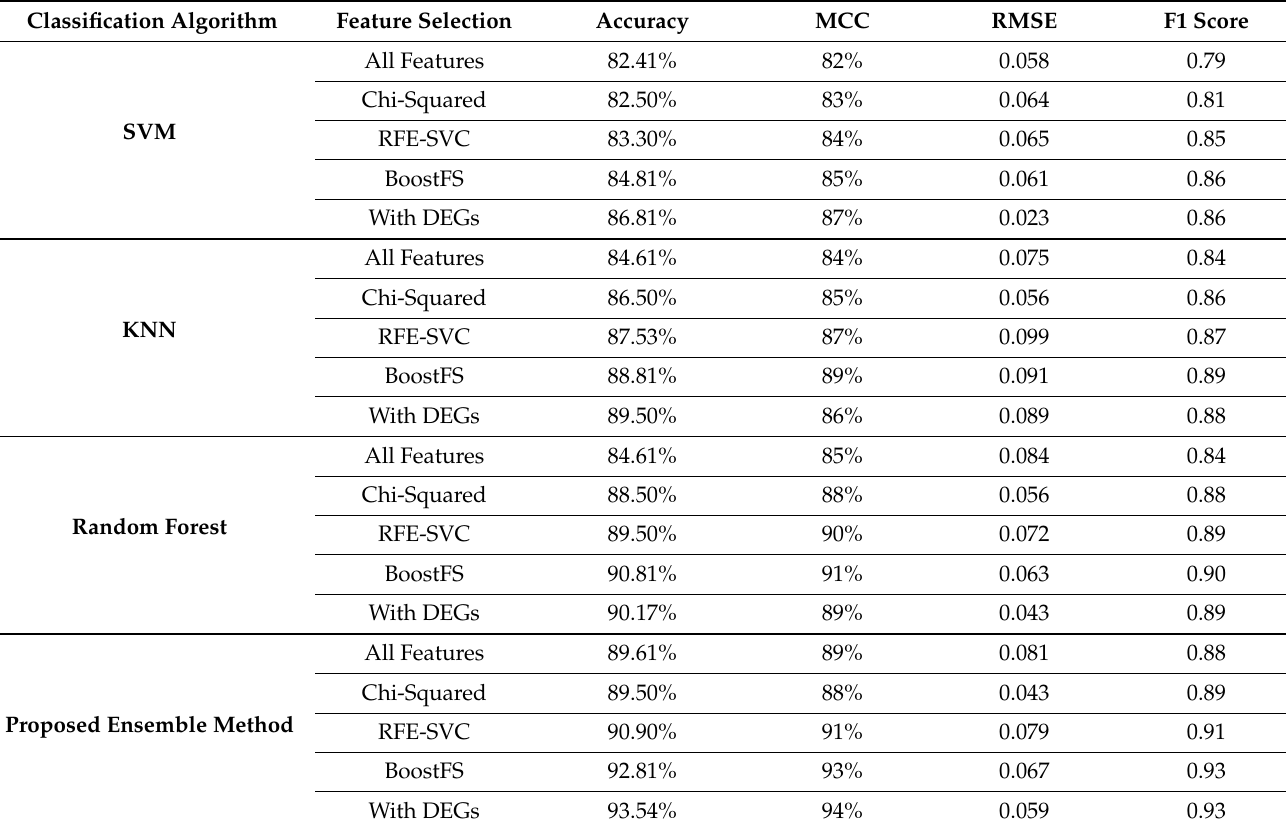
Table 8. Proposed MS detection approach evaluation.